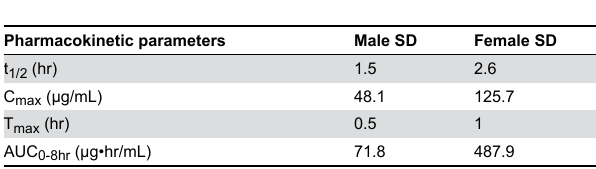
Table 2. PK parameter estimates after oral administration of E2110 to male SD, female SD rats and female SHRs.